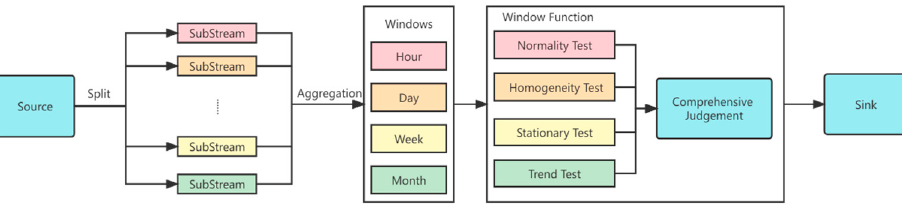
Figure 3. Flink processing flow.